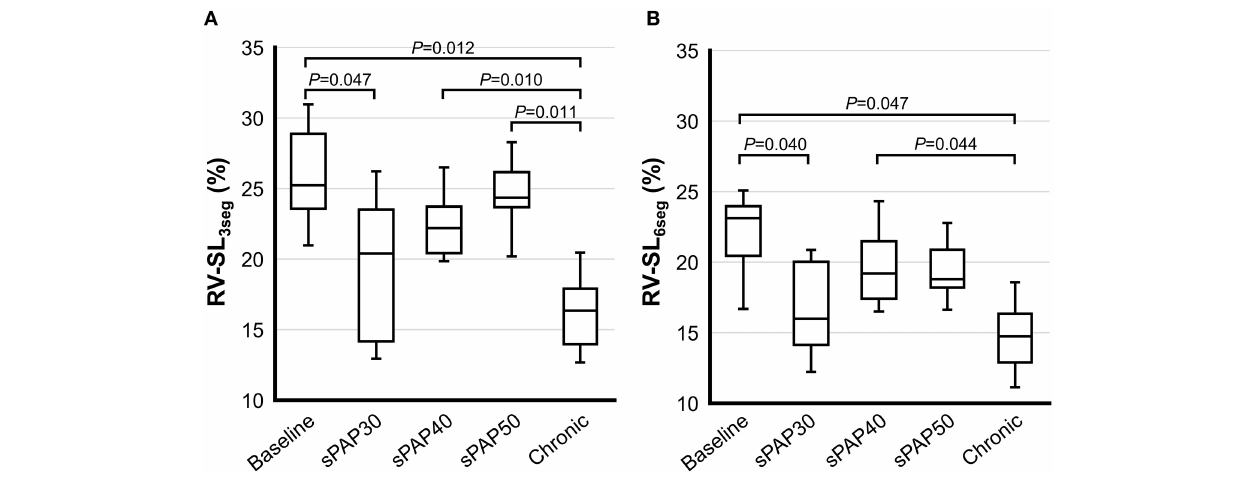
FIGURE 2 | Box and whisker plots of the right ventricular longitudinal strain (RV-SL) obtained from two-dimensional speckle tracking echocardiography. The bottom of the box is 25%, the middle line is the median, the top of the box is 75%, and the whiskers represent the range. (A) RV-SL of the right ventricular free wall (RV-SL 3seg ). (B) RV-SL of the global right ventricle (RV-SL 6seg